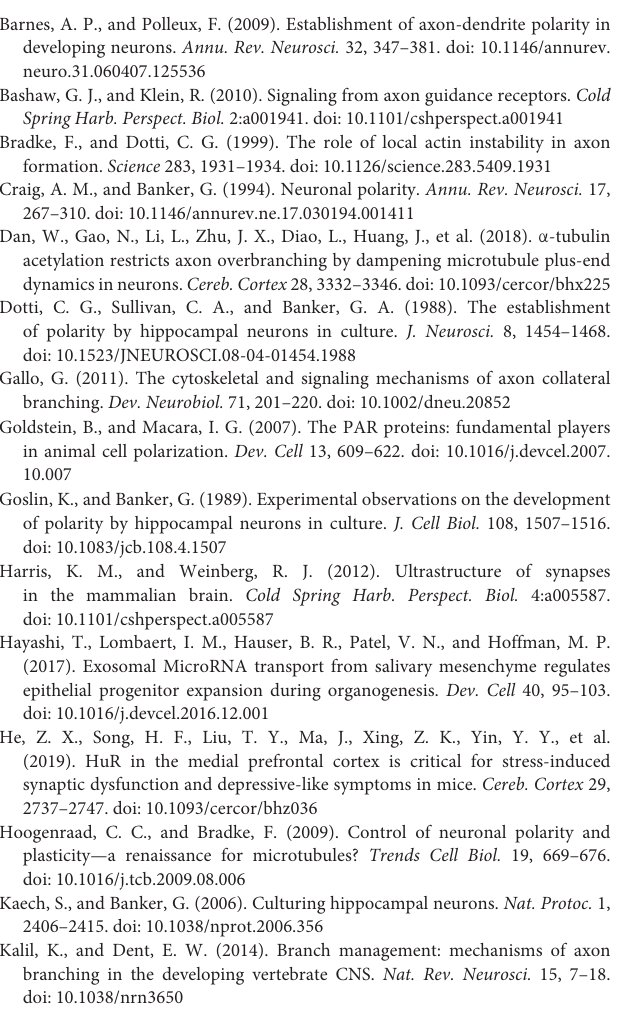
FIGURE S3 | CaiC domain is critical for DIP2B regulating axon outgrow. (A) WT mice neurons transfected with DIP2B-1-333, DIP2B-334-992 and DIP2B-993-1574 constructs that fusion with enhanced GFP, respectively, then stained with the GFP antibodies at DIV 4 (WT+GFP, n = 25; WT+DIP2B-1-333, n = 24; WT+DIP2B-334-992, n = 22; WT+DIP2B-993–1574, n = 21) Scale bar: 20 µ m. Quantitative analysis of the total axon length results shown in (B) . (C) Coomassie blue staining of purified GST-DIP2B-Caic shown in the red frame, which was semi quantitative with BSA loading. Protein bands for liquid chromatography-tandem mass spectrometry were exhibited in frame that pulls down from murine brain lysate. (D) GO biological process analysis of proteins identified from liquid chromatography-tandem mass spectrometry. (E) Microtubule related proteins found in LC-MS/MS. (F) Interaction of DIP2B and α -tubulin. HEK293T cells were co-transfected with pCDNA3.1DIP2B and α -tubulin-GFP. Cell lysates were immunoprecipitated with anti-myc and GFP antibody respectively. One-way ANOVA was used for comparisons. ns, non significant; * p < 0.05; n, cell number. Error bars represent SEM. For further details, see Supplementary Table S1 . TABLE S1 | Detail data